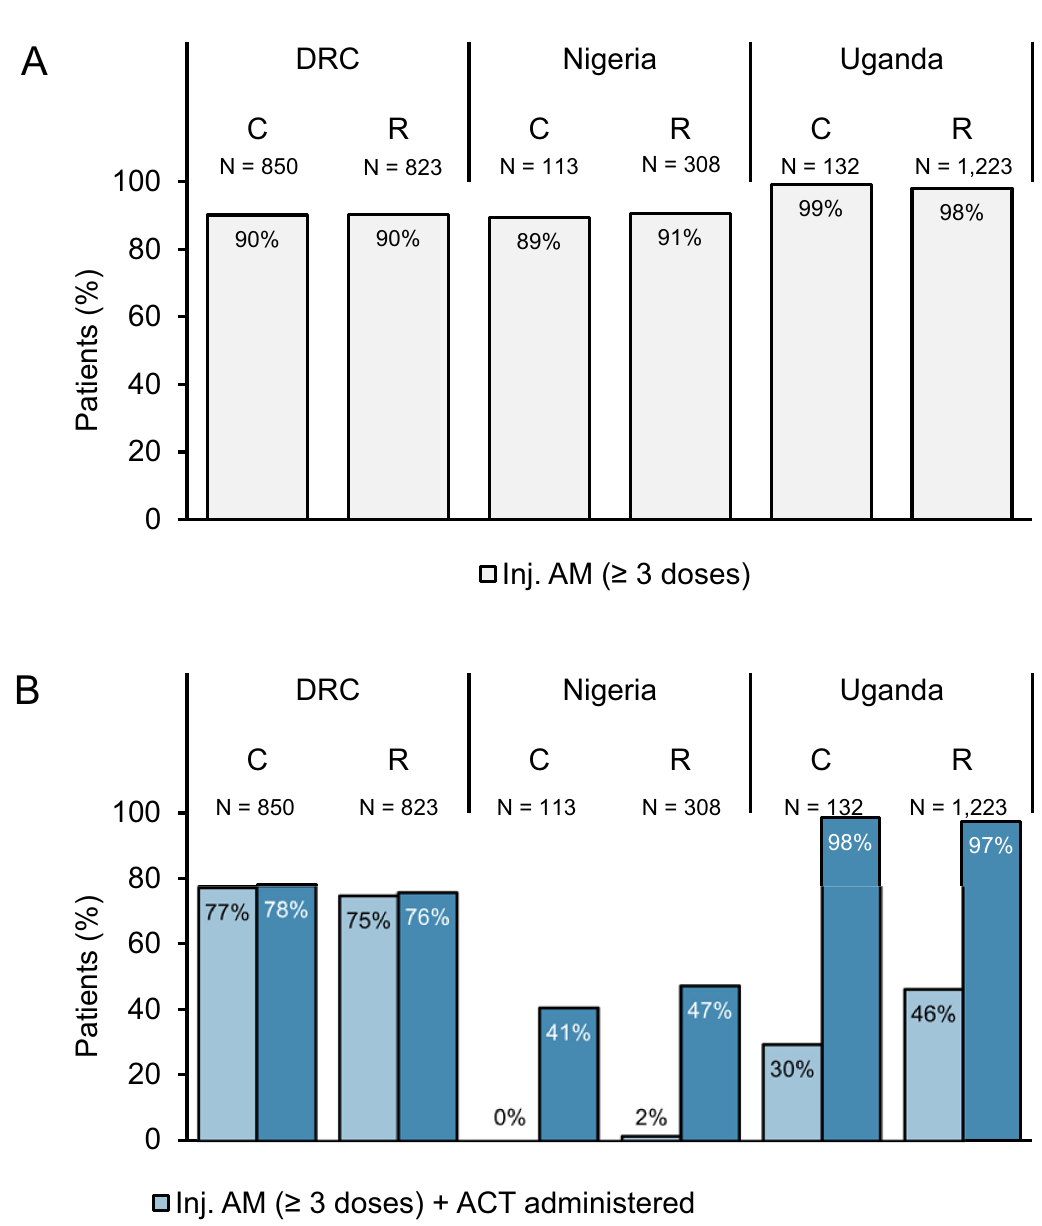
Fig 3. Antimalarial treatment compliance for children diagnosed with severe malaria after the implementation of RAS, by country and by enrolling provider (%). Antimalarial treatment administered in-hospital or prescribed at discharge to children referred by a CHW or PHC (C) or directly attending an RHF (R). (A) Administration of at least 3 doses of an injectable antimalarial (artesunate, artemether, or quinine). (B) Administration of at least 3 doses of an injectable antimalarial and in- hospital follow-on ACT (light blue bars) or in-hospital administered/at discharge prescribed/dispensed follow-on ACT (dark blue bars). Data collection period: Uganda and DRC: April 2019–July 2020, Nigeria: May 2019–July 2020. ACT, artemisinin- based combination therapy; AM, antimalarial; DRC, Democratic Republic of the Congo; RAS, Rectal Artesunate; RHF, Referral Health Facility.